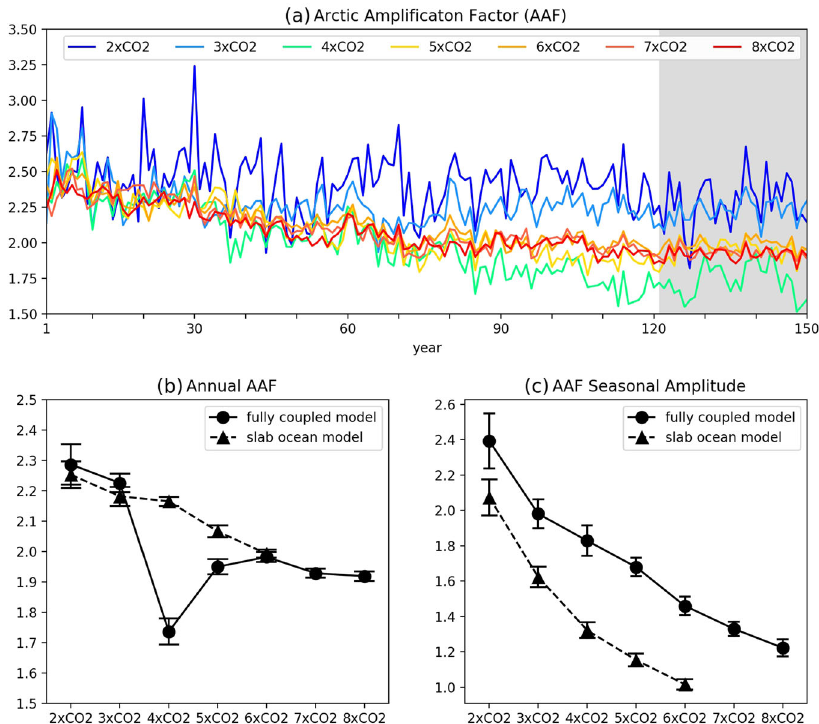
Fig. 3 Time evolution and annual-mean amplitude of the AAF in the abrupt CO 2 forcing experiments. a The evolution of the annual AAF for 2× to 8 × CO 2 in fully coupled model experiments. The last 30-year period is shaded with grey. b Annual-mean AAFs as functions of CO 2 forcing. c The AAF annual amplitude or seasonal range, de fi ned as the maximum AAF minus minimum AAF of the mean seasonal cycle response. In b and c , the solid line with circle symbols represents responses for the fully coupled model experiments, whereas the dashed line with triangle symbols for the slab ocean model experiments. Error bars denote 95% con fi dence intervals calculated using Student ’ s t